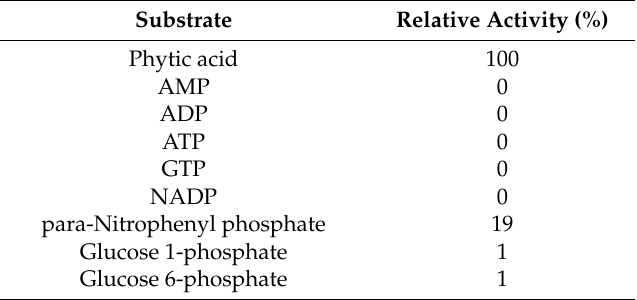
Table 1. Substrate specificity of PhyRC001, shown by the relative activity of PhyRC001 for different substrates.